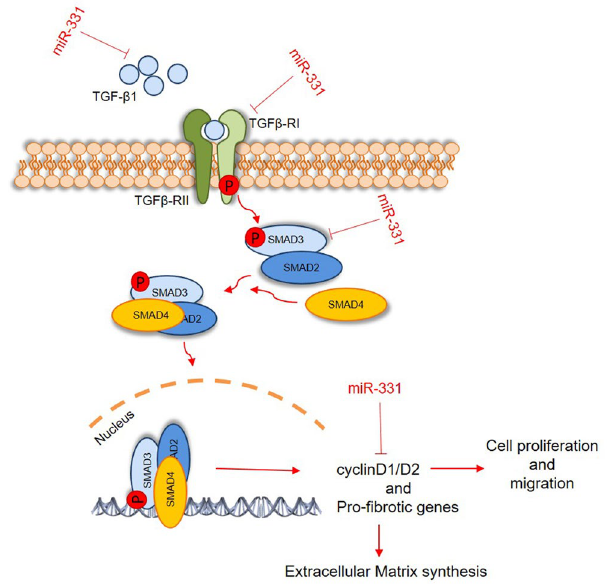
Figure 6. Schematic representation of TGFβ pathway regulation by miR-331. In this model, miR-331 by targeting some genes (TGFβ-R1, TGFβ-1, SMAD2, and SMAD3) results in reduced TGFβ signaling pathway activity which in turn, effects the fibrotic genes expression of cardiac myofibroblasts and other related biological processes, including cell proliferation and